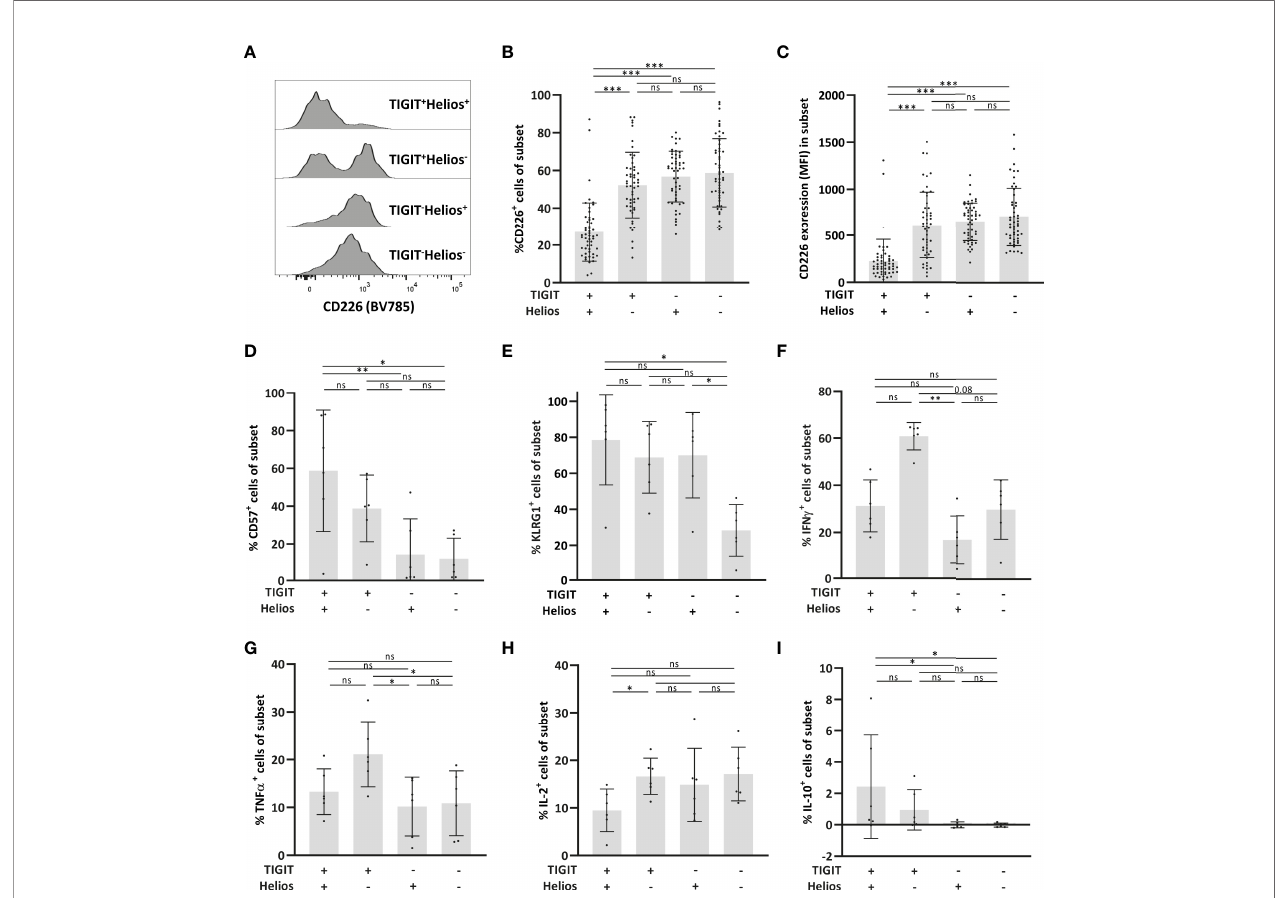
FIGURE 2 | Low expression of the co-stimulatory receptor CD226 by immunosenescent CD8 + T cells. (A) Representative histogram of CD226 expression within each of the TIGIT/Helios cell subsets. Bar graphs show (B) the frequency of CD226 + cells and (C) expression (median fl uorescent intensity, MFI) of CD226 per cell within each of the four TIGIT/Helios cell subsets (n = 50). Bar graphs show the frequency of (D) CD57 + and (E) KLRG1 + cells within each of the four TIGIT/Helios cell subsets (n = 6). Bar graphs show the frequency of (F) IFN- g + , (G) TNF- a + , (H) IL-2 + , and (I) IL-10 + cells within each of the four TIGIT/Helios cell subsets in response to PMA/ionomycin. Statistical signi fi cance of data presented in the bar graphs (means ± s.d.) was determined using Friedman test (with Dunn ’ s post-test). (* p < 0.05, ** p < 0.01, *** p < 0.001, ns, not signi fi